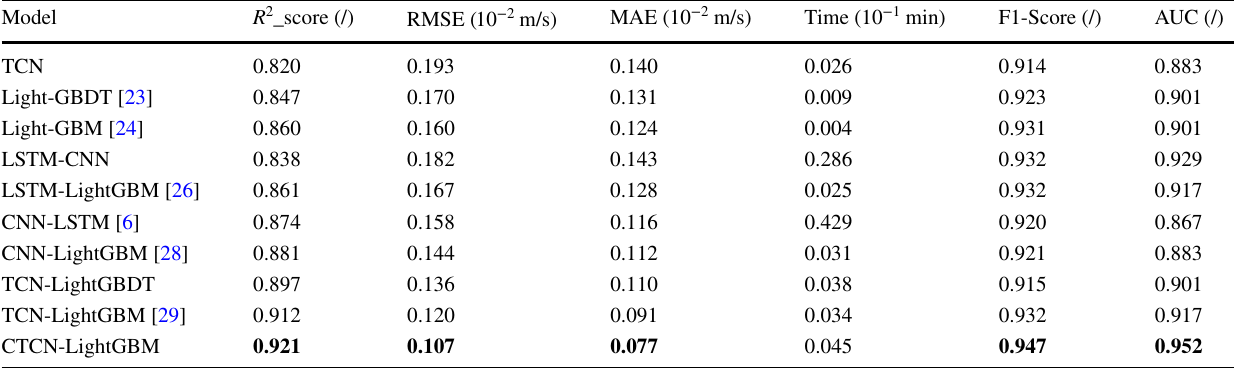
The bold values indicate superior metric values of the proposed CTCN-LightGBM Table 16 The prediction and classification results of all models for the chute flow adjustment